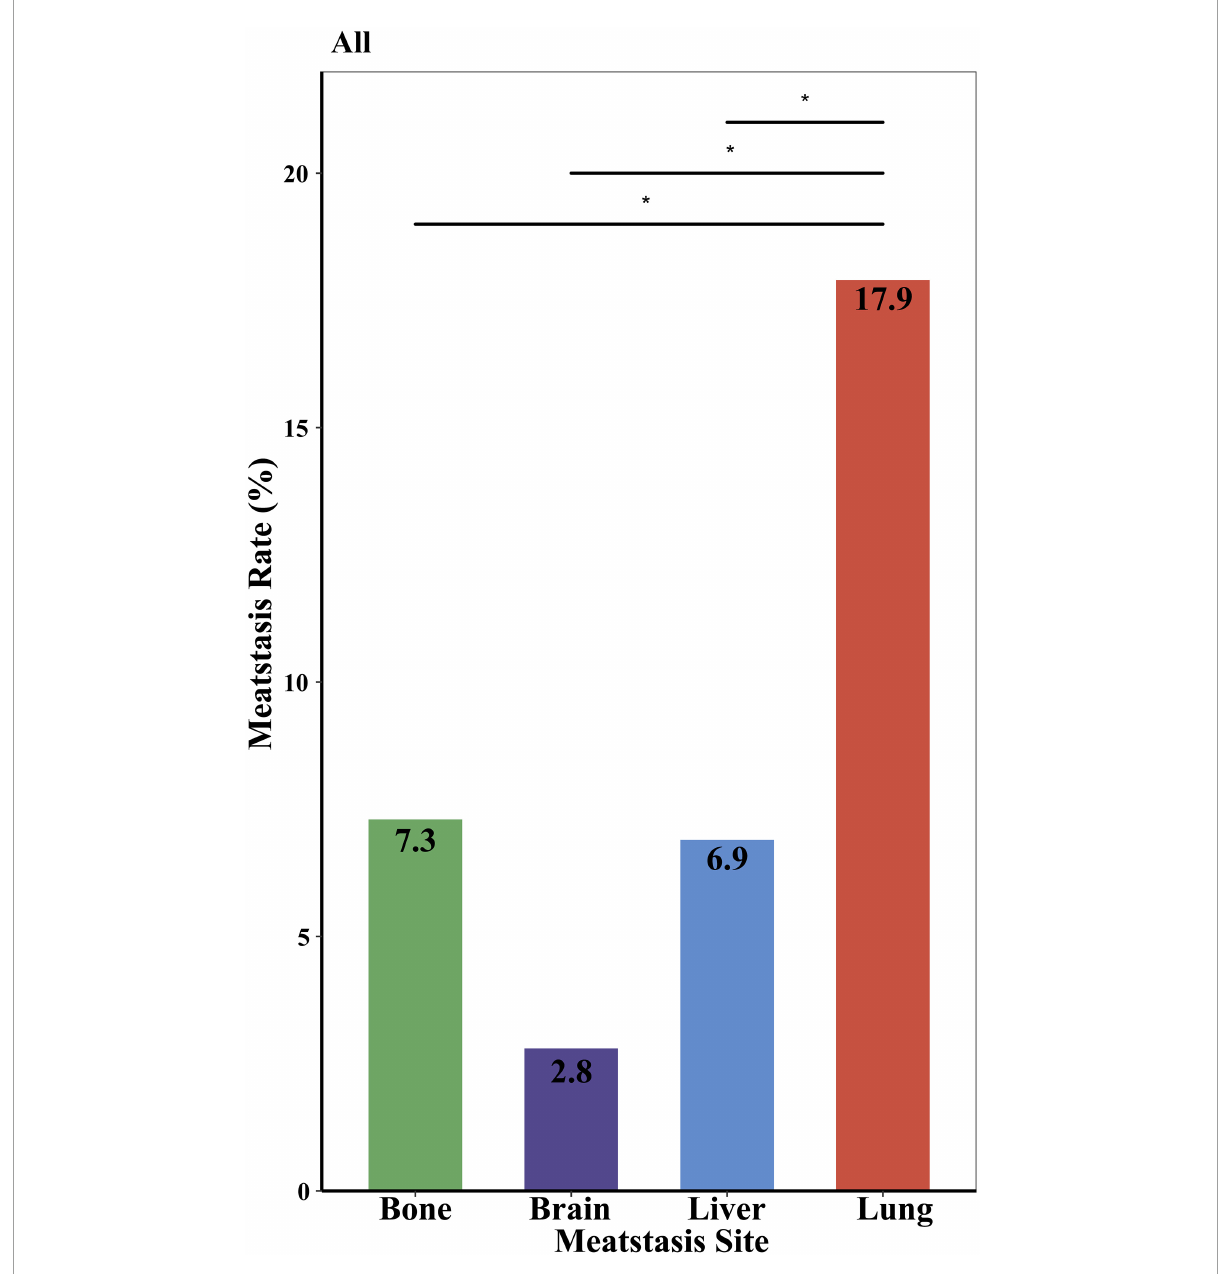
FIGURE1 Incidence of distant metastases in different metastatic sites. * P < 0.05.